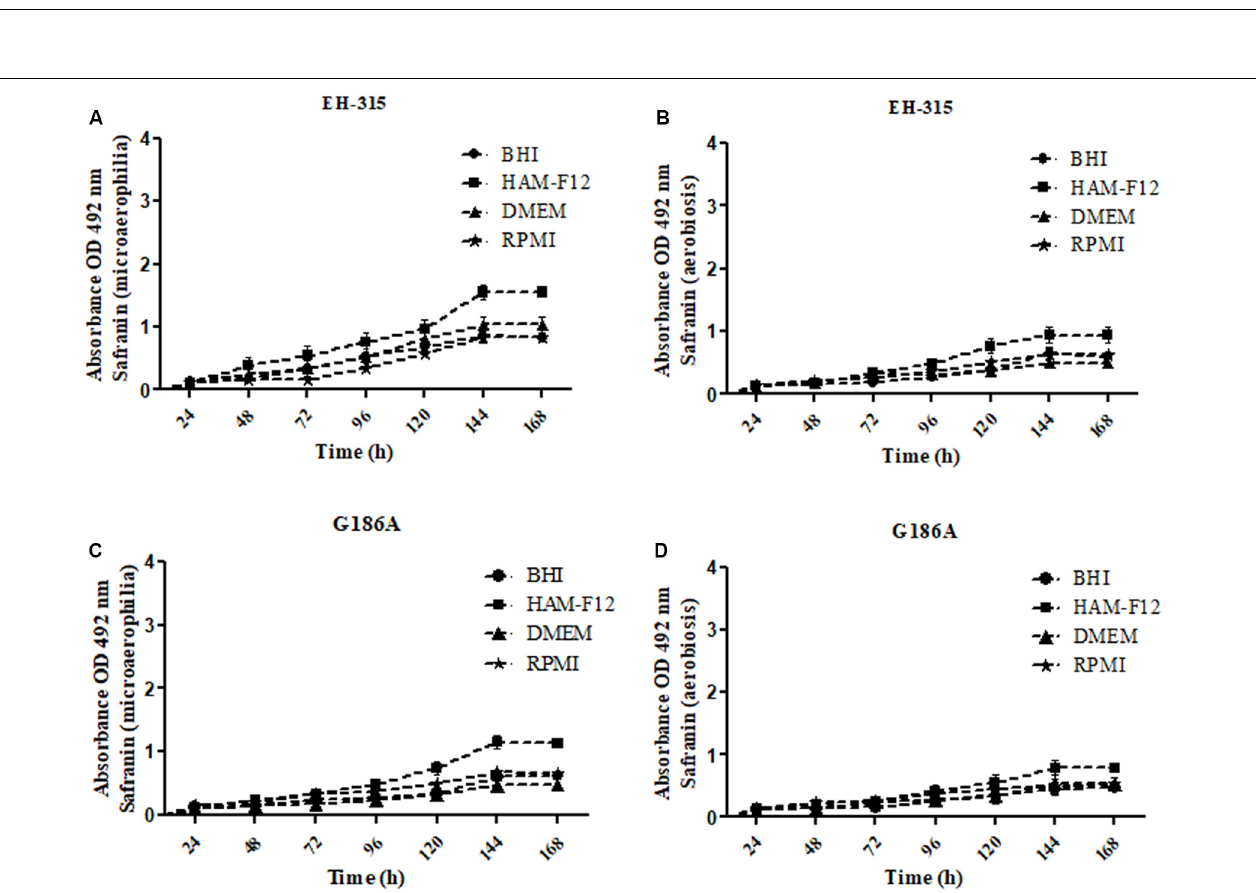
FIGURE 5 | Kinetics of the amounts of extracellular matrix and other external polysaccharides of biofilms formed by different strains of H. capsulatum (A,B) EH-315 and (C,D) G186A in microaerophilia (A–C) and aerobiosis (B–D) conditions.